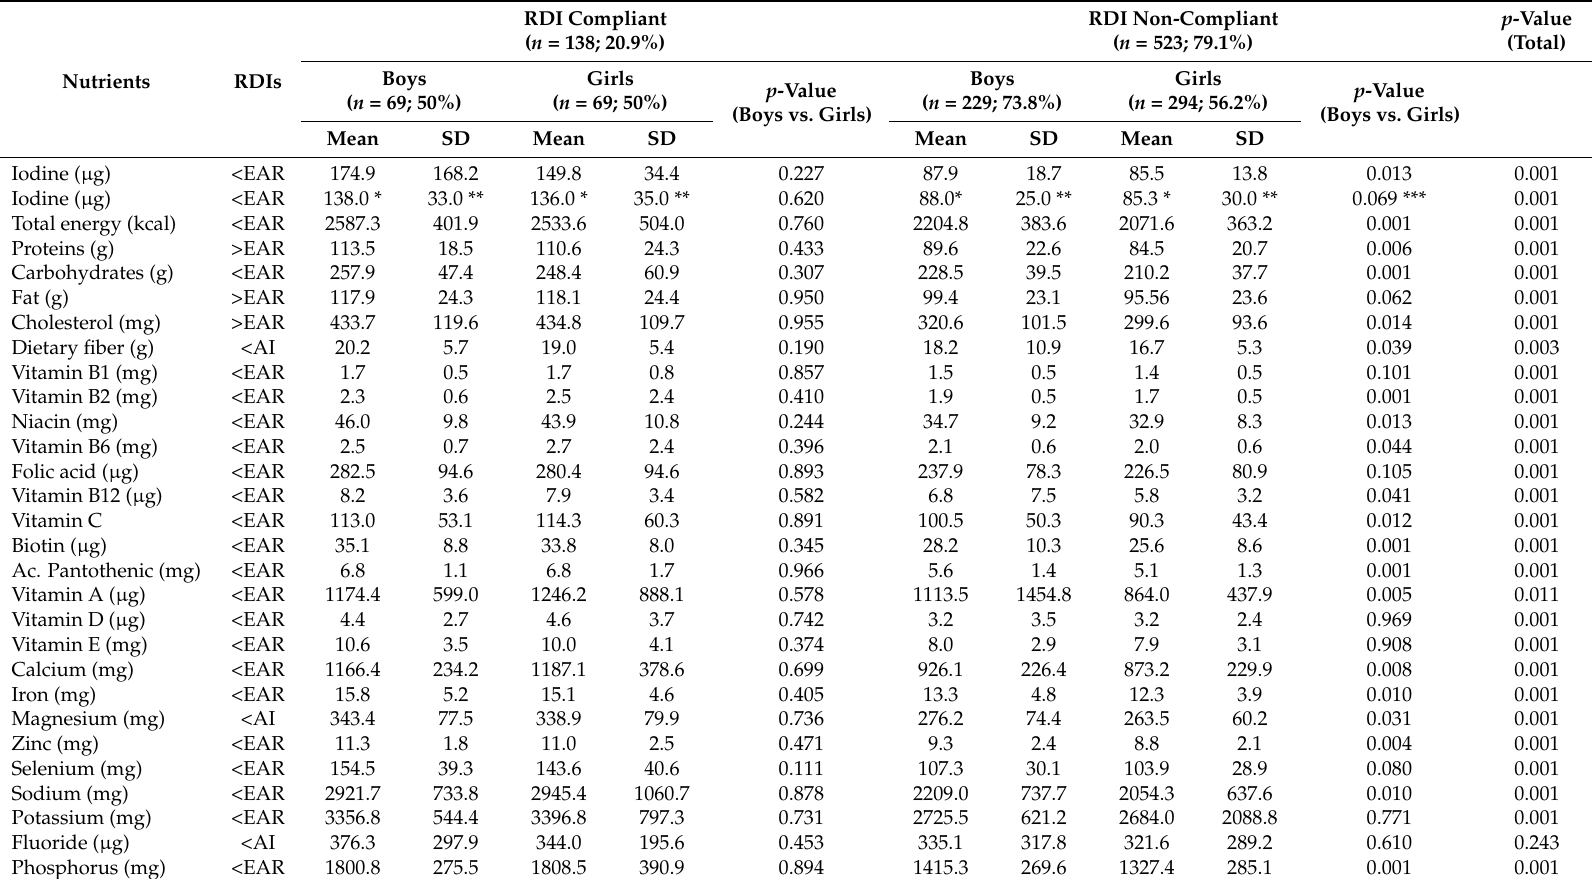
Table 2. Nutritional insufficiency in relation to iodine and gender